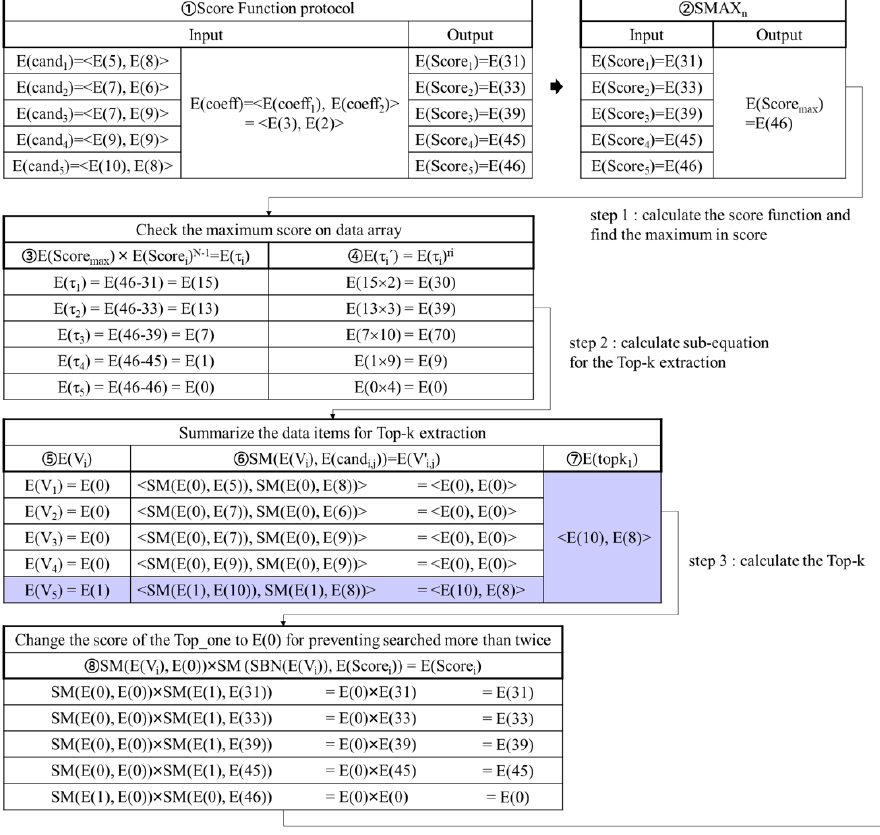
Figure 6. Example of Top- k retrieval